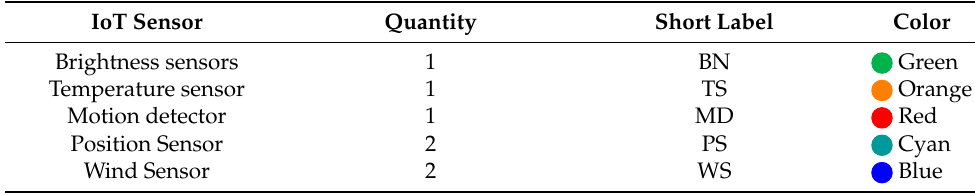
Table 4. IoT sensors used in Smart Office scenario with short label and color.